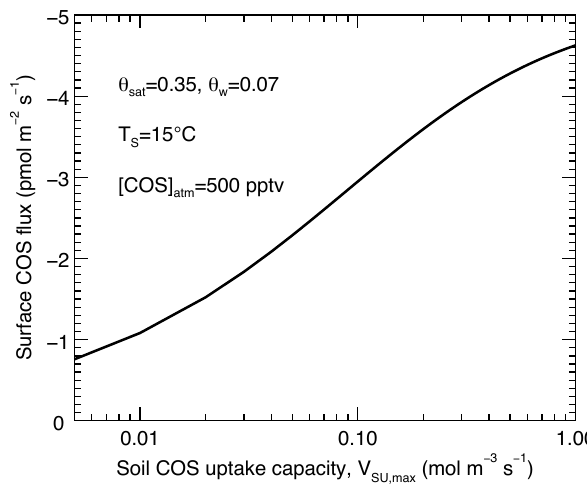
Figure 10. An idealized numerical experiment to test the sensitivity of COS flux to soil COS uptake capacity, with θ sat = 0 . 35m 3 m − 3 , θ w = 0 . 07m 3 m − 3 , soil temperature at 15 ◦ C, and ambient COS concentration at 500pmolmol − 1 . Note that the x axis is in loga- rithmic scale and the y axis is reversed for showing COS uptake.